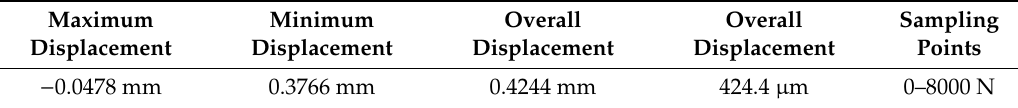
Figure 8. Tappet movement and displacement measurement result. Table 3. Laser displacement-sensor experiment results.